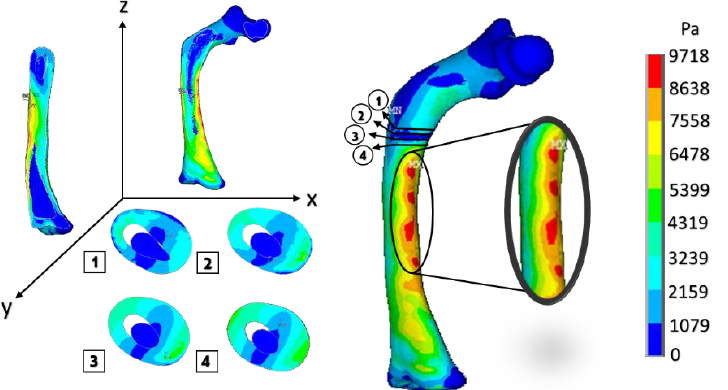
Figure 19. Isotropic analysis of the oblique fracture case. Von Mises stress showing maximum stress of 9.718 Pa.